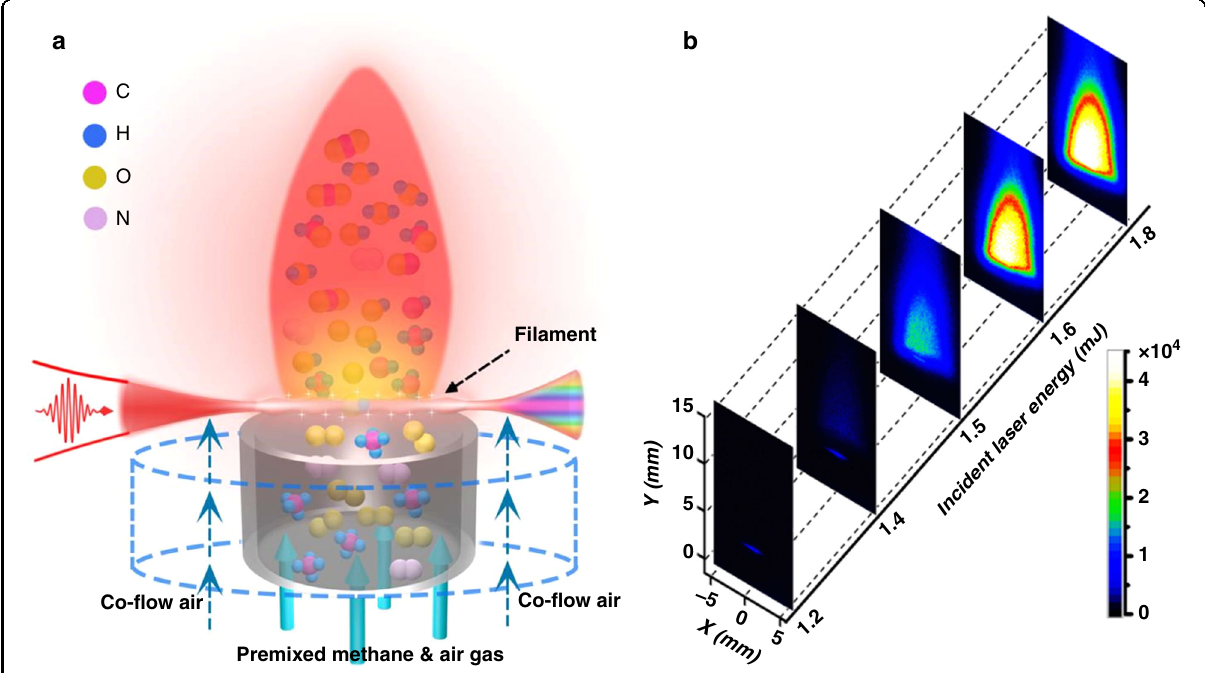
Fig. 1 Laser fi lament ignition concept and ultralow-energy-threshold ignition images. a Schematic diagram of the ultrashort laser fi lament ignition of a premixed lean methane/air mixture fl ow. b Side-view images of the methane/air mixture fl ow irradiated by an intense fs laser fi lament at different incident laser